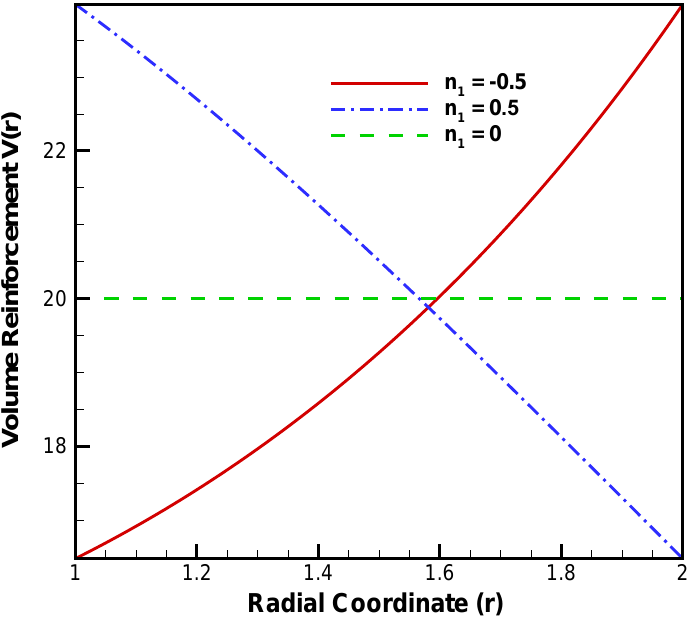
Figure 2. Exponential volume reinforcement ( vol %) of SiC p in Al metal matrix along radius r (in cm) of